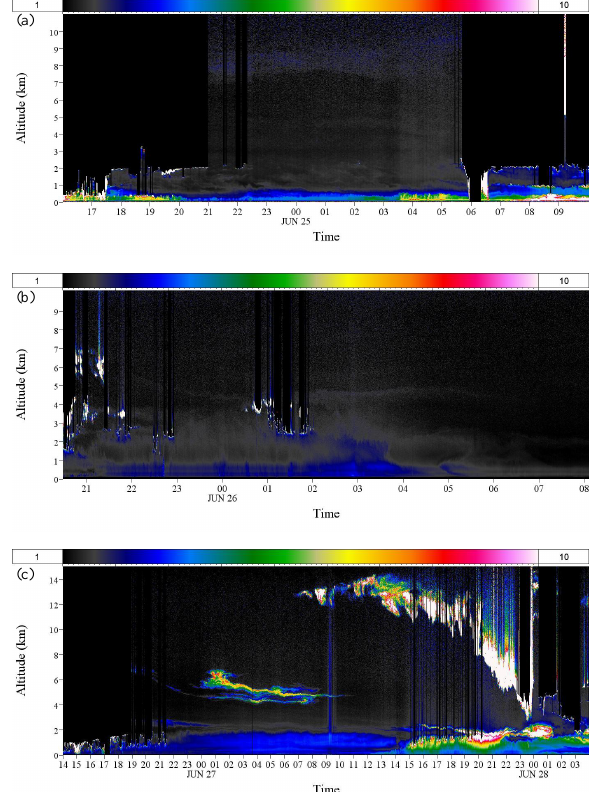
Fig. 8. False colour plots (using the same colour scale) showing the lidar backscatter ratio at 1064nm for (a) CORALNet UBC, (b) CORALNet BLO and (c) CORALNet Egbert. The time and date (in 2011) are plotted in UTC.